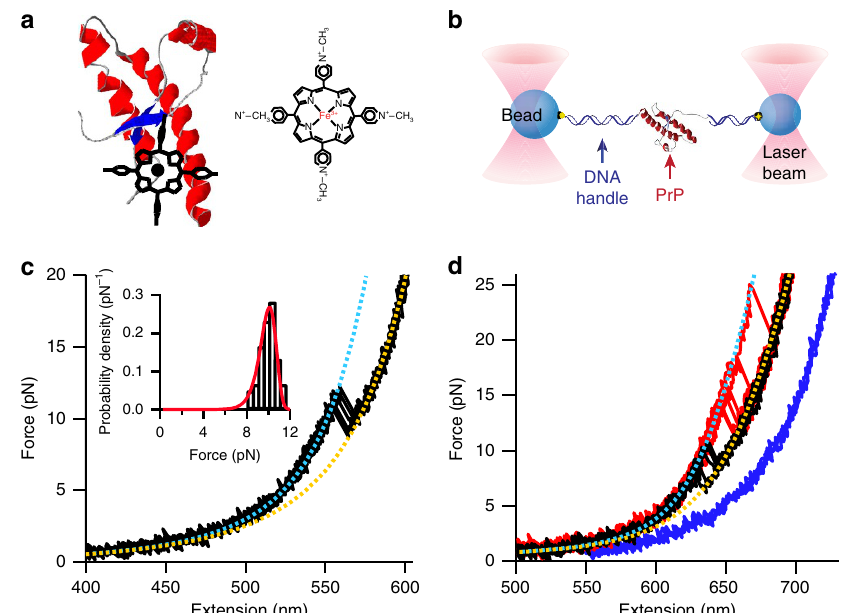
Figure 1 | Force spectroscopy of PrP with Fe-TMPyP. ( a ) Structure of Fe-TMPyP (right). Fe-TMPyP binds PrP C in a pocket as shown on left, interacting with the C terminus of helix 3, N terminus of helix 2, the helix 2-strand 2 loop and strand 1 (model based on ref. 47). ( b ) Schematic of force spectroscopy assay. PrP was attached covalently to DNA handles linked to polystyrene beads held by laser beams. ( c ) FECs in the absence of Fe-TMPyP (black), fit by WLC models for the folded (cyan) and unfolded (yellow) states, show a single unfolding event with a narrow unfolding force distribution (inset; N ¼ 200) peaked near 10pN. Red line: fit to equation 3. ( d ) With 50 m M Fe-TMPyP, three types of FECs were observed, reflecting different states of the protein: natively folded but ligand-free (black), natively folded but ligand-bound (red) and ligand-bound but native structure disrupted (blue). Total number of FECs: 120. The unfolding force distribution for FECs with discrete transitions is much broader than without